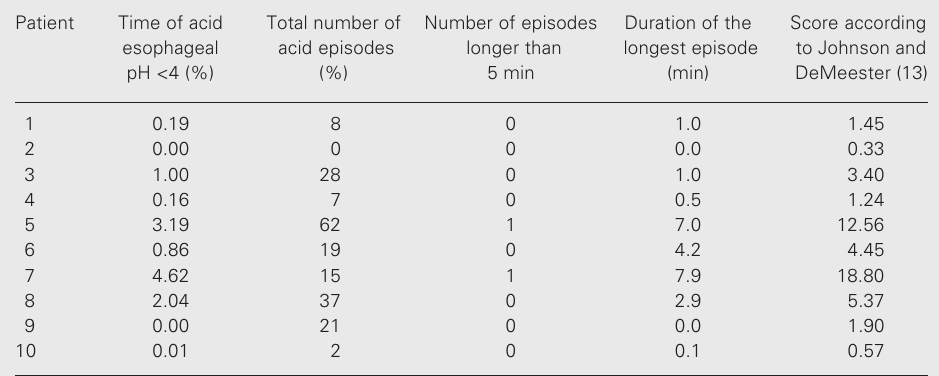
Table 2. Results of 24-h esophageal pH monitoring of 10 children and adolescents with chronic and/or recurrent